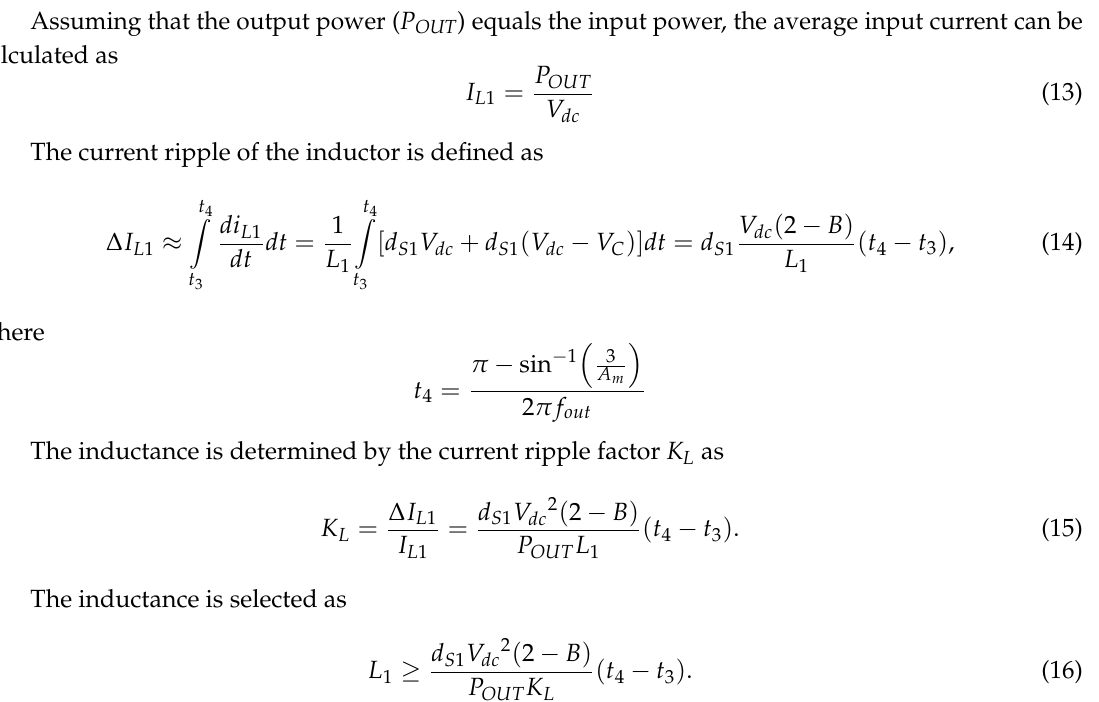
Figure 6. Inductor current ripple and capacitors voltage ripple.